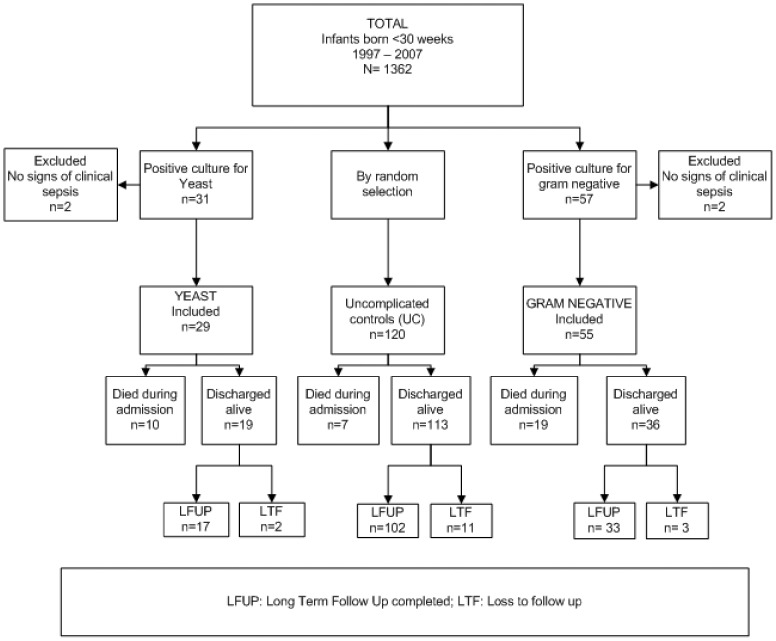
Population Flow sheet.LFUP: Long Term Follow Up completed; LTF: Loss to follow up.